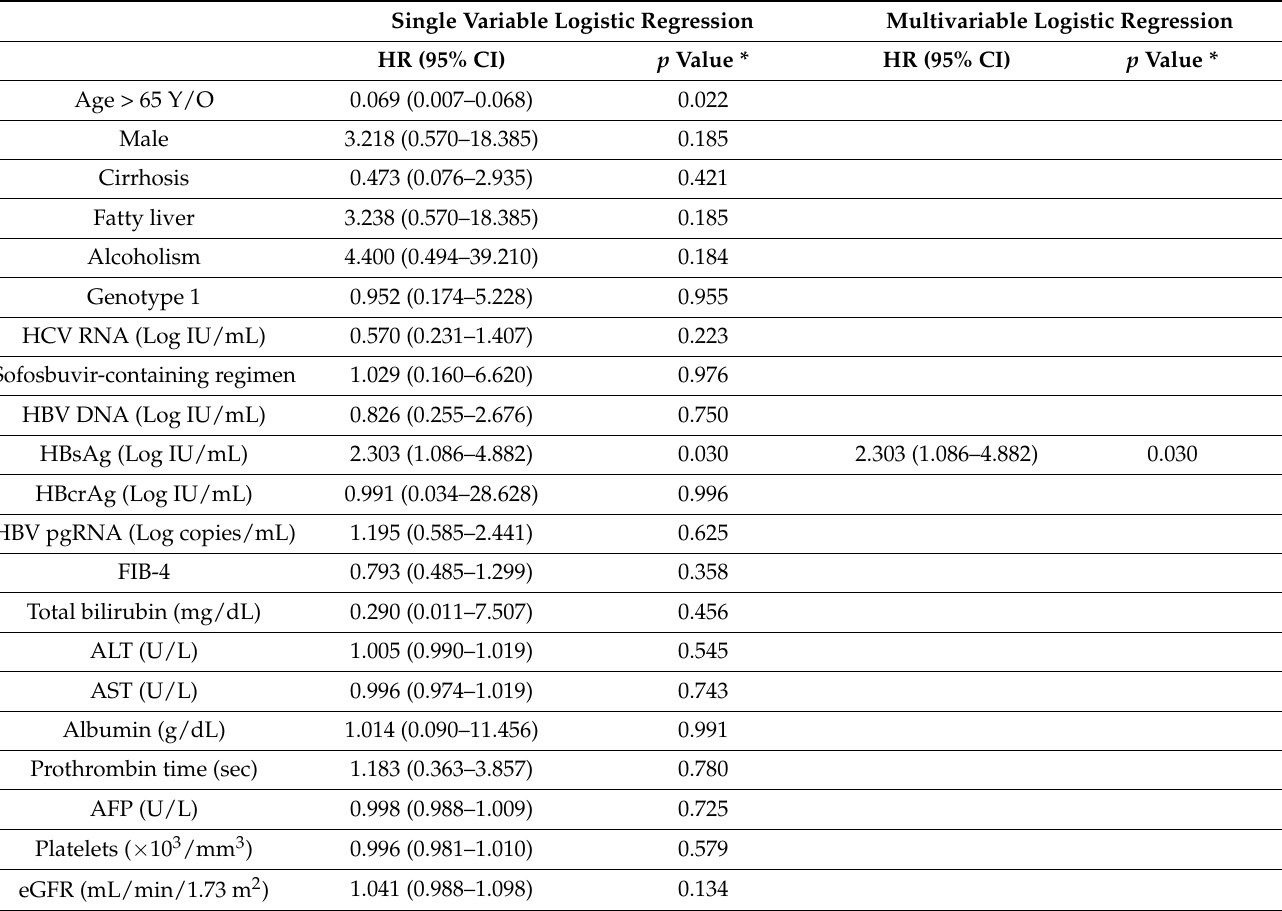
Table 3. Predictive factors for HBV reactivation in HBV/HCV coinfected patients receiving DAA therapy without nucleot(s)ide analogue treatment ( n =